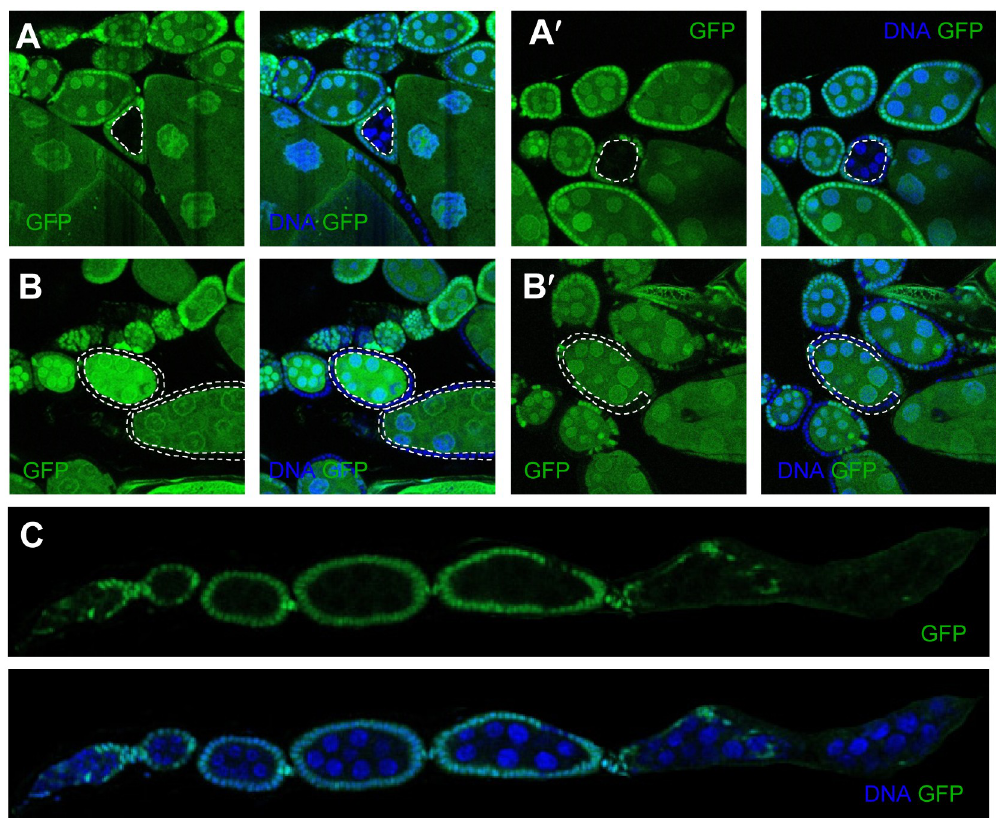
Fig 2. Mkrn1 function was required in germline cells, but not follicle cells, for egg chamber growth. (A, B) Mkrn1 exS cells are marked by the absence of GFP (green). Posterior egg chambers consisting of Mkrn1 exS germline cysts and wild-type follicle cells were abnormally smaller than the anterior egg chambers (A and A 0 ). Egg chambers with wild-type germline cysts and mutant follicle cells grew normally and proceeded to vitellogenic stages (B and B 0 ). (C) Ovarioles with all egg chambers had Mkrn1 exS mutant germline cysts and wild-type follicle cells phenocopied the Mkrn1 exS mutant. The dashed line indicates the Mkrn1 -null